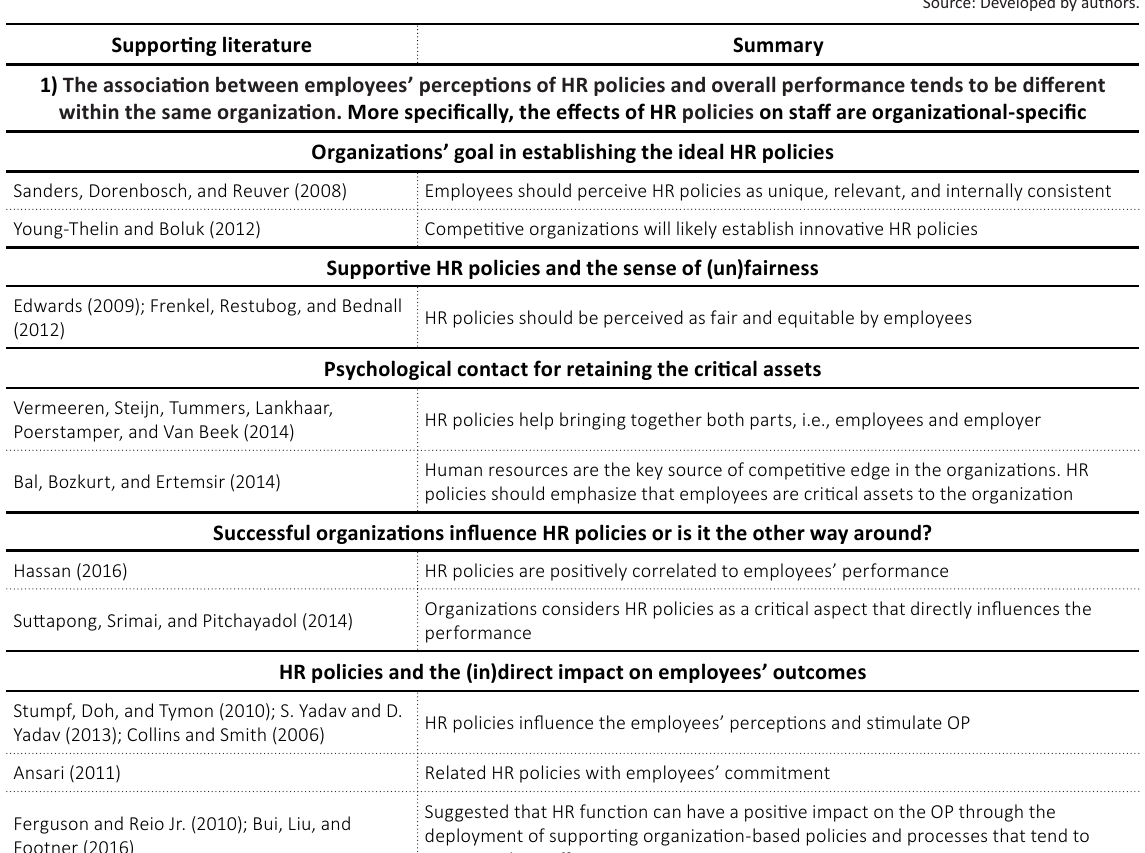
Table 2. Workers’ behavior and individual performance